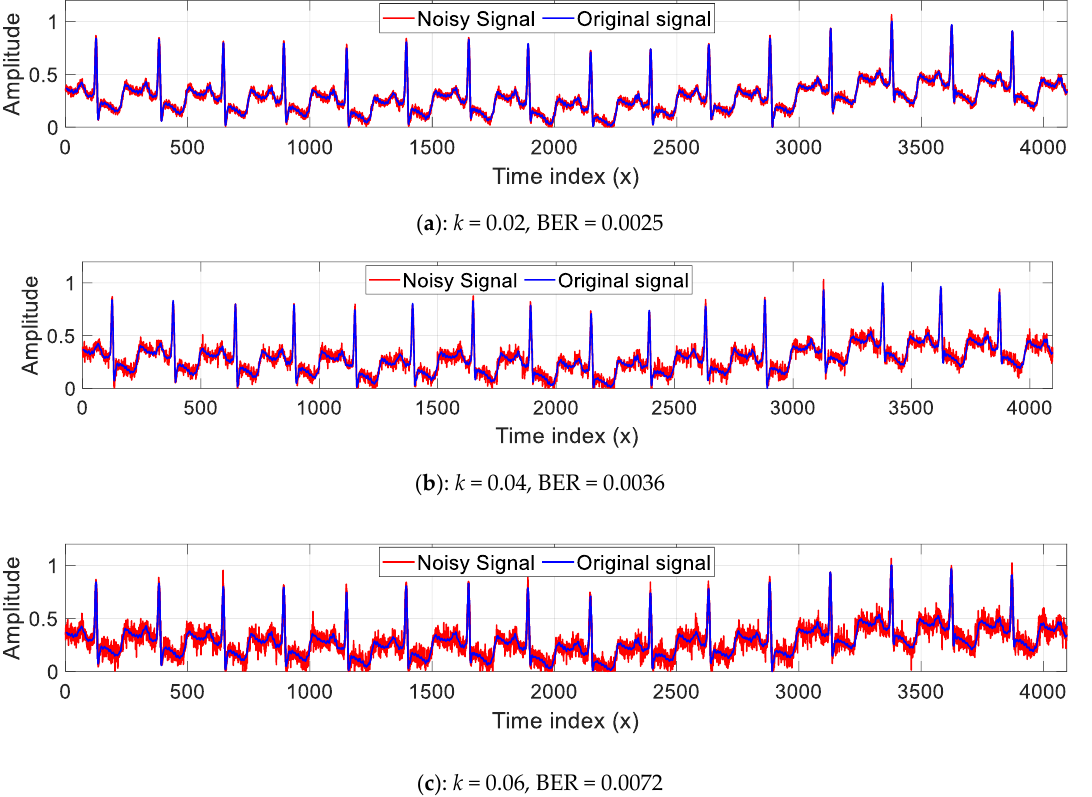
Figure 16. Noisy ECG signal frame of size N = 4096 with Gaussian noise of k-strength and the corresponding BER values.